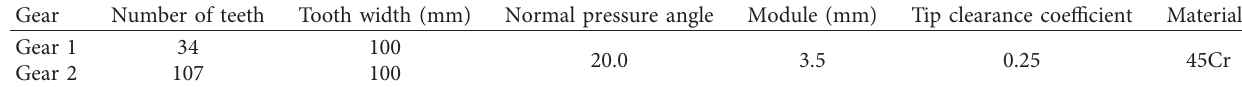
Table 1: Geometric parameters of gear pairs.